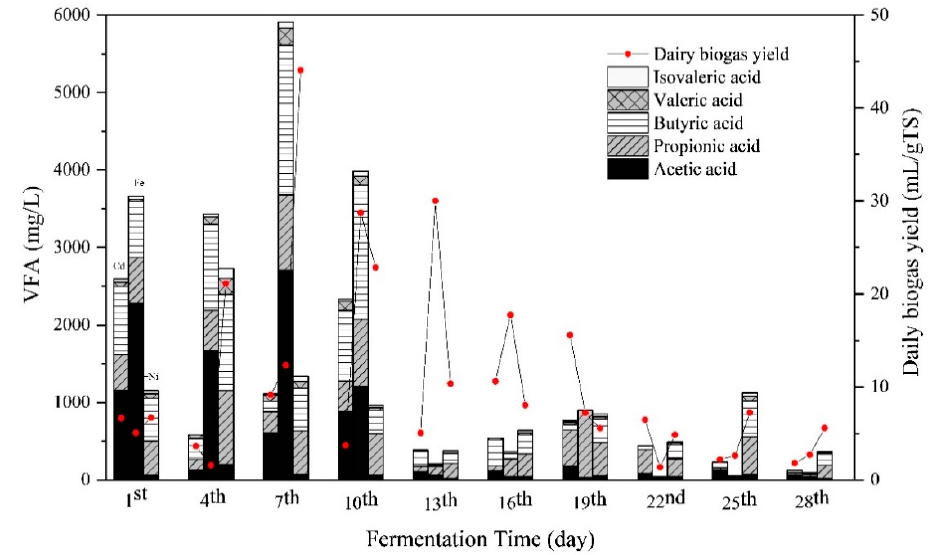
Figure 4. Impact of Cd, Cd + Fe, and Cd + Ni addition on volatile fatty acids (VFAs) and daily biogas yield during the fermentation.